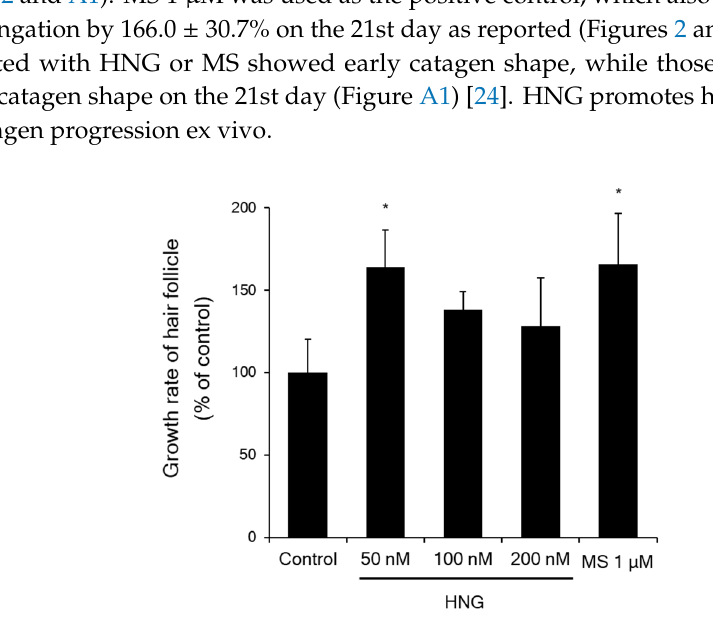
Figure 2. HNG increases hair shaft elongation. Vibrissa follicles in anagen phase were treated with HNG from 50 to 200 nM for 21 days. Media was refreshed every three days. The mean growth rate of the vibrissa follicle of control group on the 21st day was set as 100%. Data are shown as the mean ± S.E.M. * p < 0.05 vs. control.